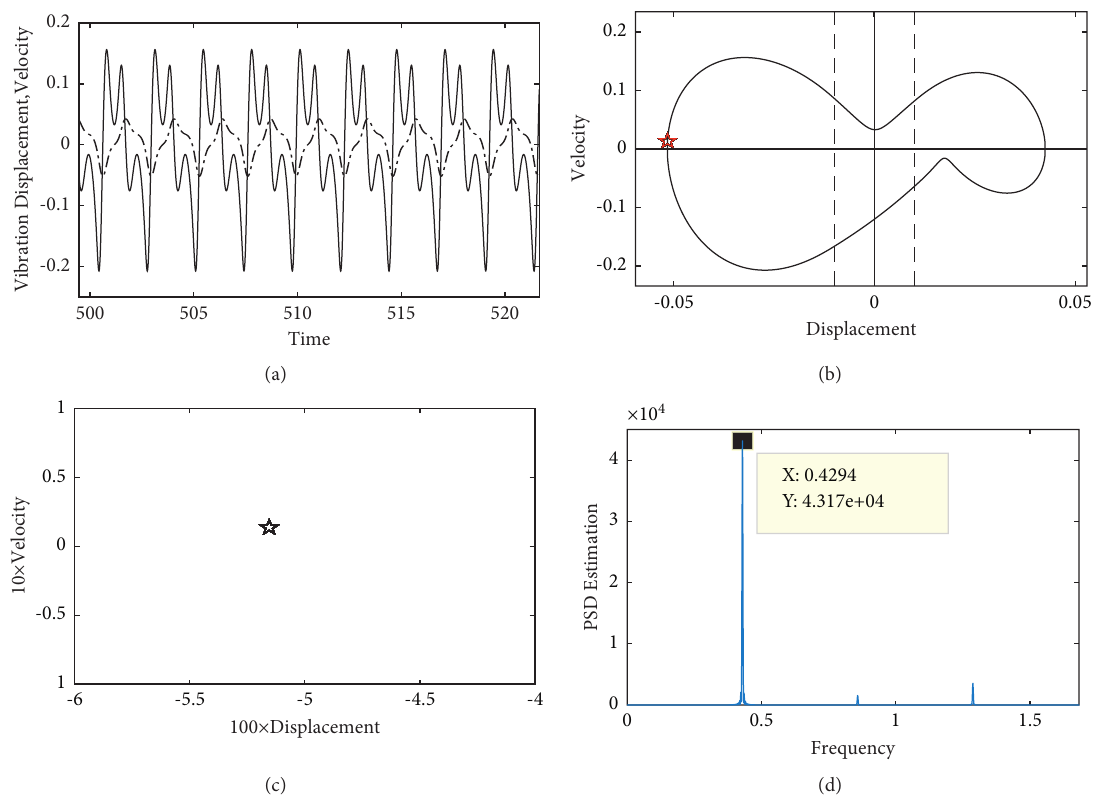
Figure 5: f � 0 . 429 Hz ， asymmetric period 1-1-1. (a) Time history graph. (b) Phase diagram. (c) Poincar´e section. (d) Power spectral density diagram.